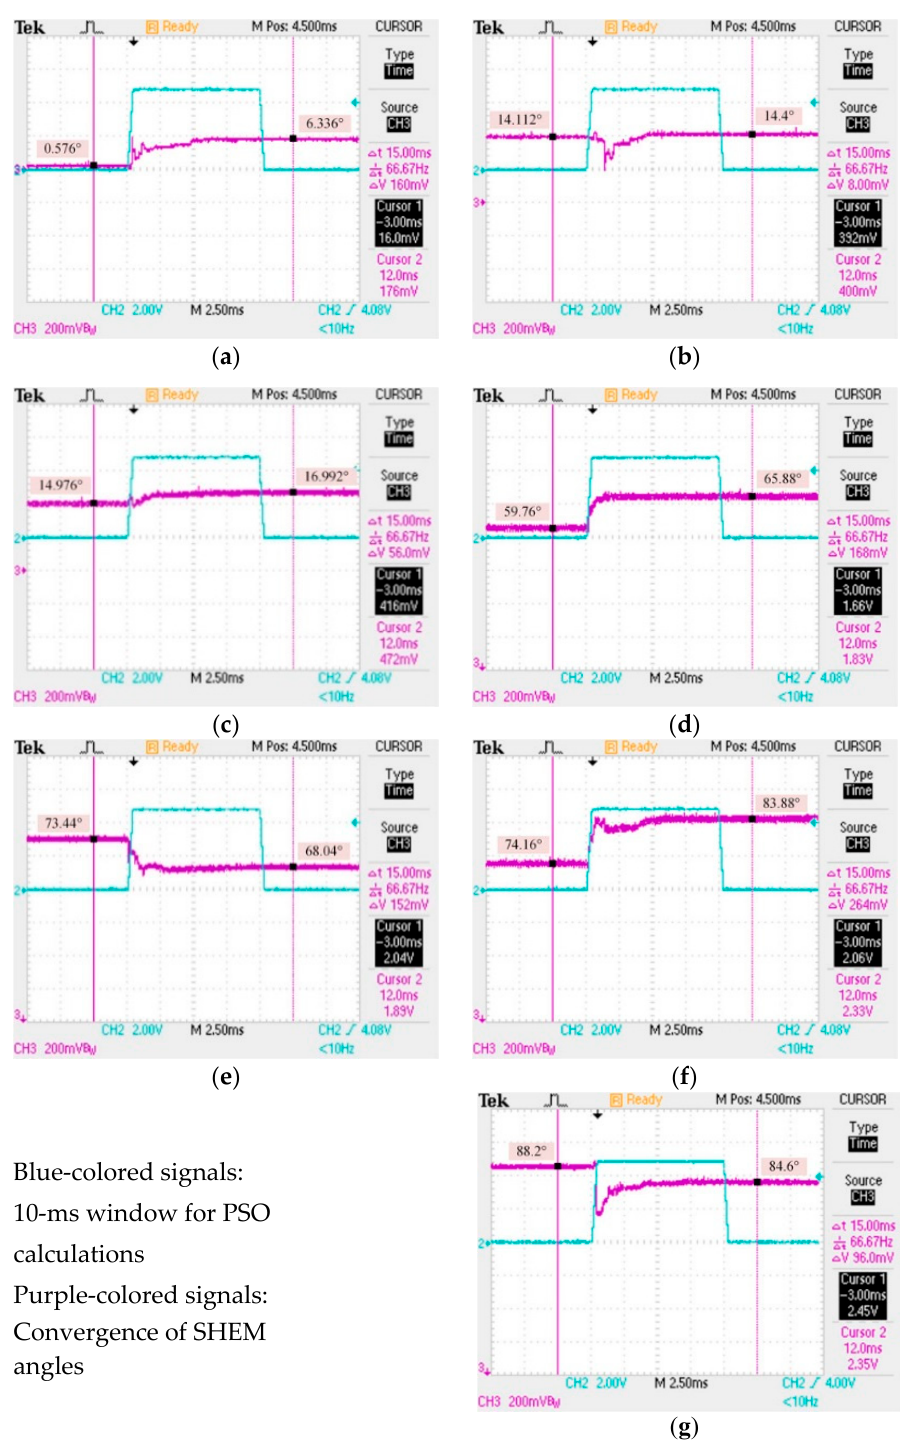
Figure 12. Online calculation of SHEM angles for a step change in M from M = 0.1 to 0.9. ( a ) α 1 , ( b ) α 2 , ( c ) α 3 , ( d ) α 4 , ( e ) α 5 , ( f ) α 6 , ( g ) α 7 (5 V ≡ 180°).